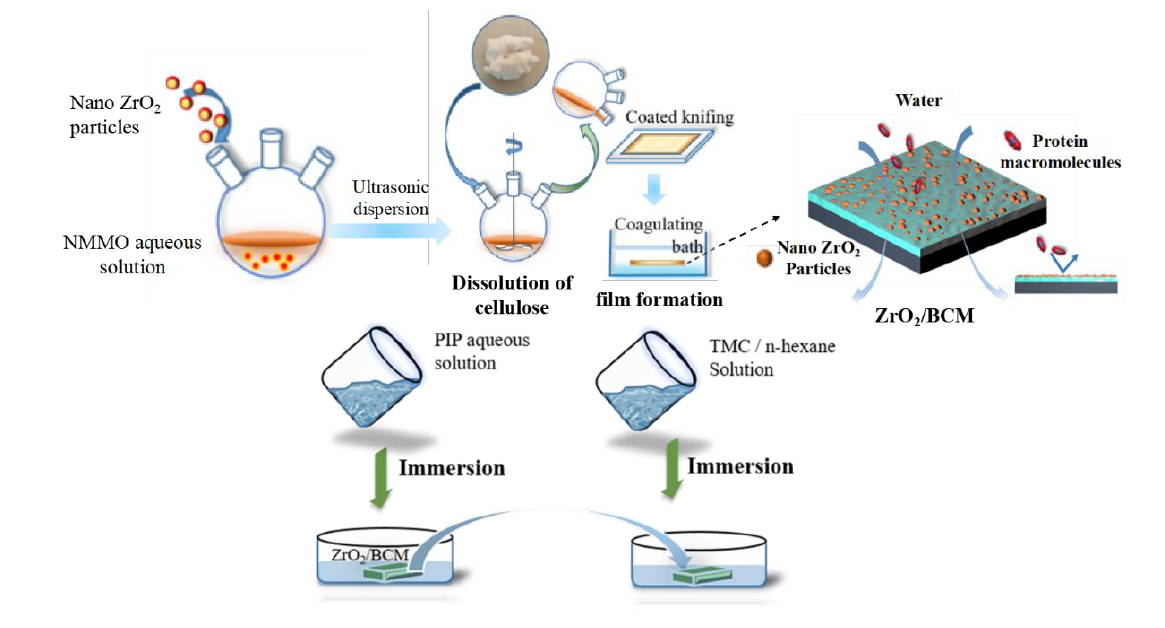
Figure 1. Preparation scheme for IP − ZrO 2 /BC − NFM.